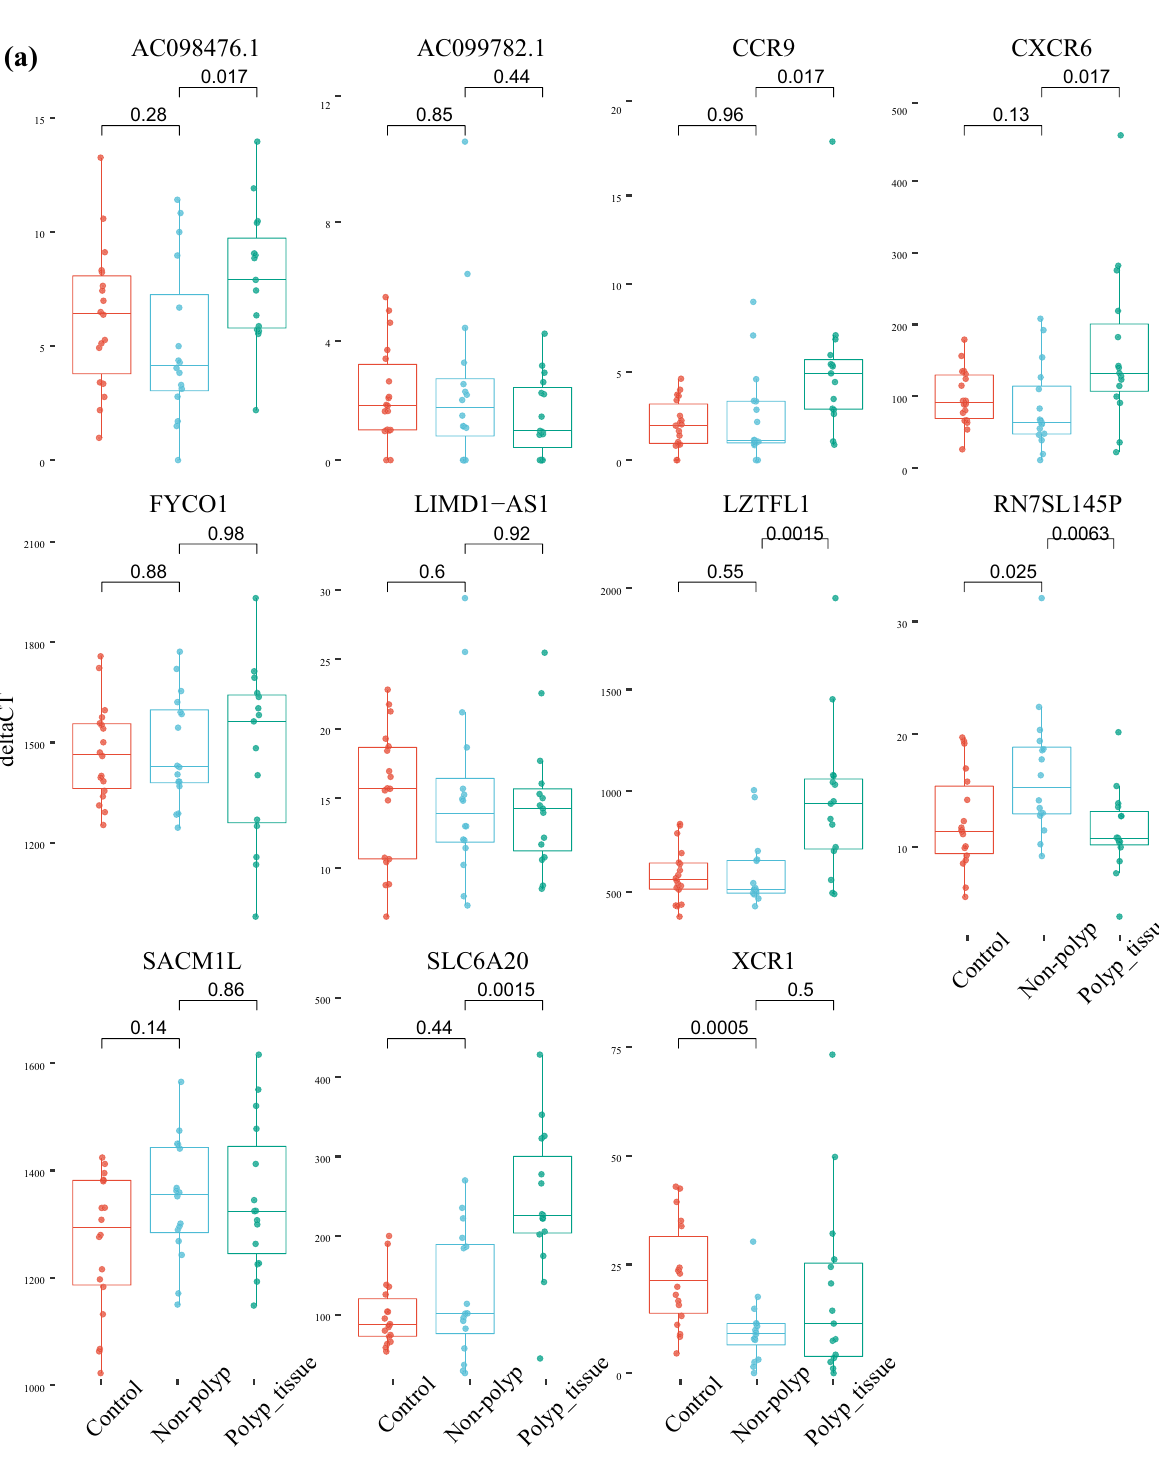
Figure 5. Differentially expressed genes (DEGs) in chromosomal regions showing genome wide significant association with COVID-19. Four chromosomal regions were included, ( a ) chromosome 3, ( b ) chromosome 12, ( c ) chromosome 19 and ( d ) chromosome